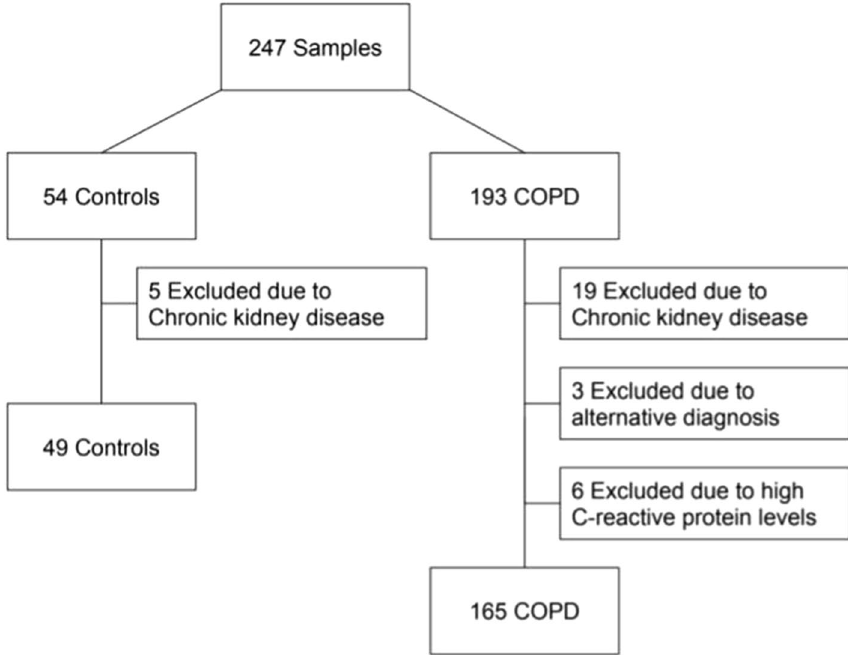
Figure 1. Flowchart for patient